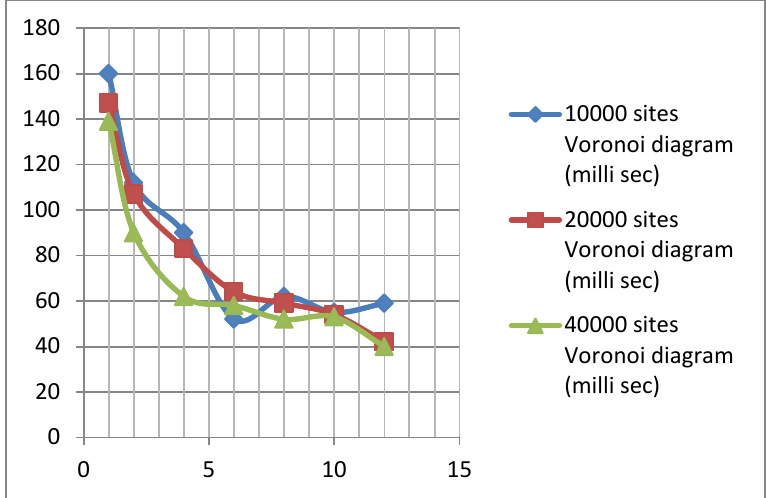
Figure 5. The execution time of 10,000 KNN queries on three Voronoi diagrams generated from 10,000, 20,000, and 40,000 sites, respectively, using 1 to 12 parallel processors.